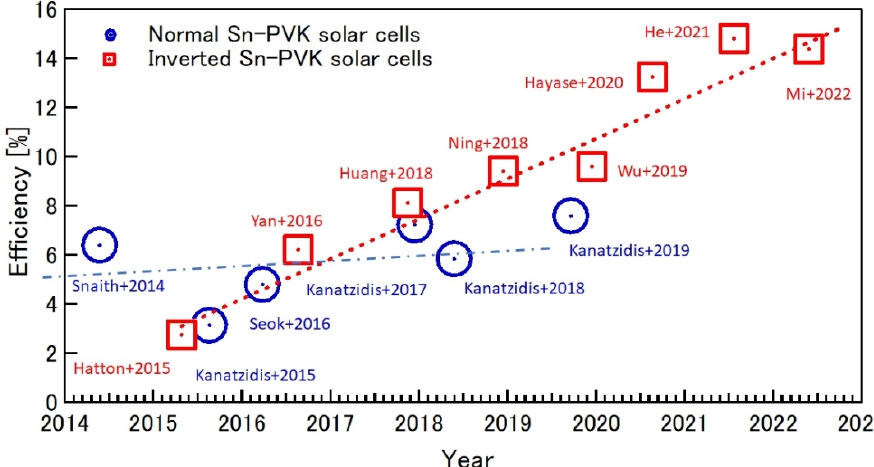
Figure 10. Efficiency evolution of Sn-PVK solar cells in regular and inverted structures over the years. Inverted structure solar cells have reached a maximum of 14.83%, while the normal structure has, to date, reached 7.59%. ( Snaith+2014 [48]; Hatton+2015 [61]; Kanatzidis+2015 [62]; Seok+2016 [63]; Yan+2016 [64]; Kanatzidis+2018 [65]; Kanatzidis+2017 [66]; Huang+2018 [67]; Kanatzidis+2019